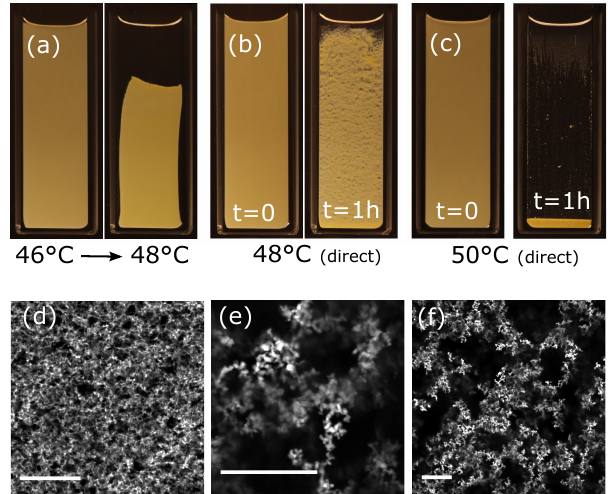
Figure 3. ( a ) Sample of 2 vol. % rods (left panel) first immersed in a water bath at 46 ◦ C, and subsequently (right panel) slowly heated in the water bath to 48 ◦ C; ( b ) Sample of 2 vol. %